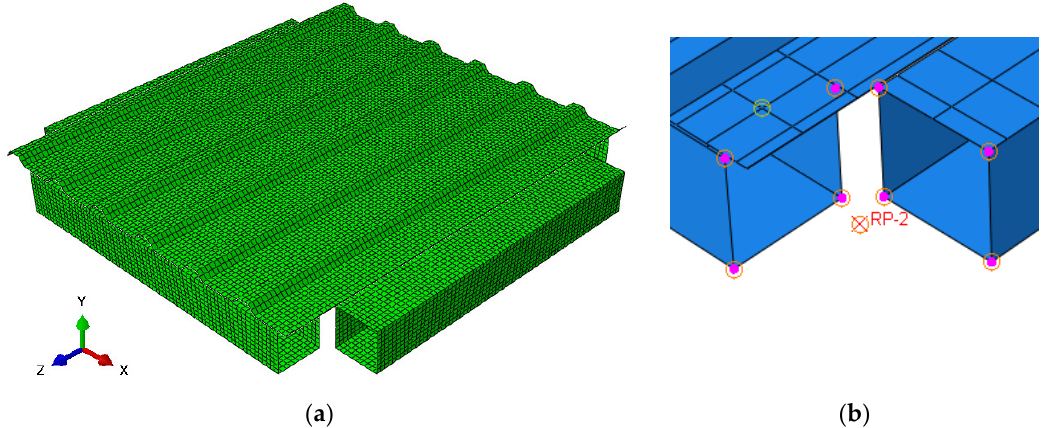
Figure 5. Numerical model: ( a ) view of the whole model with global coordinates; ( b ) detail of the frame hinge.